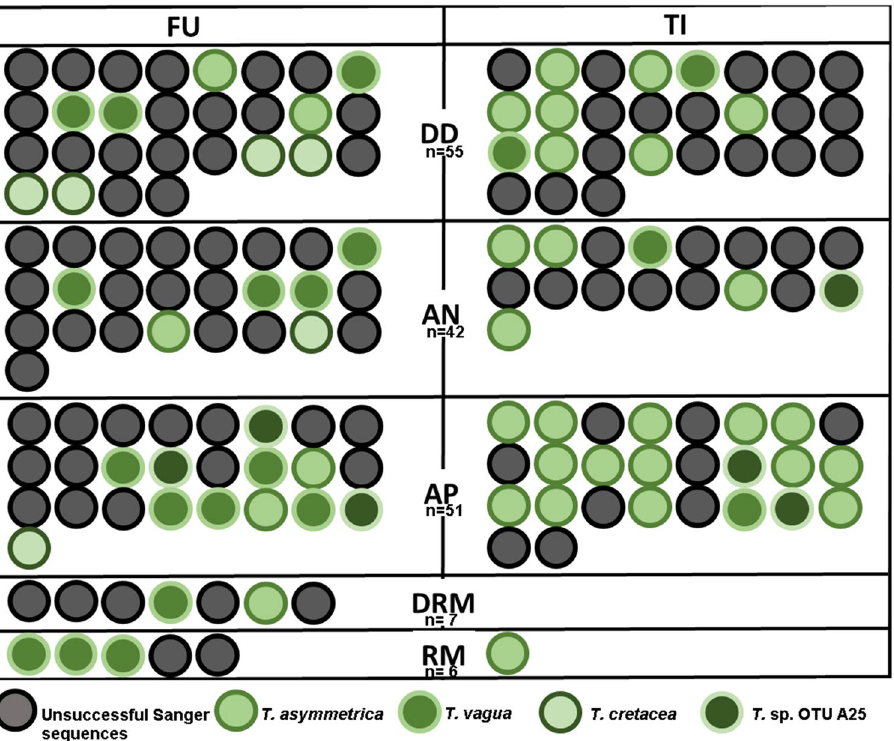
Figure 1. Sanger sequencing success and Trebouxia diversity detected in Diploschistes diacapsis (DD), Acarospora nodulosa (AN), Acarospora placodiiformis (AP), Rhizocarpon malenconianum (RM) and Diplotomma rivas-martinezii (DRM) collected in Fuentidueña de Tajo (FU) and Titulcia (TI). The total number of specimens analysed for each species is indicated (n). Sequences passing the quality filter were considered unique, showing only one predominant phycobiont (green circles). Sequences with ambiguous base calls and/or underlying peaks in the electrophoretogram were excluded from the dataset and noted as unsuccessful Sanger sequences (grey